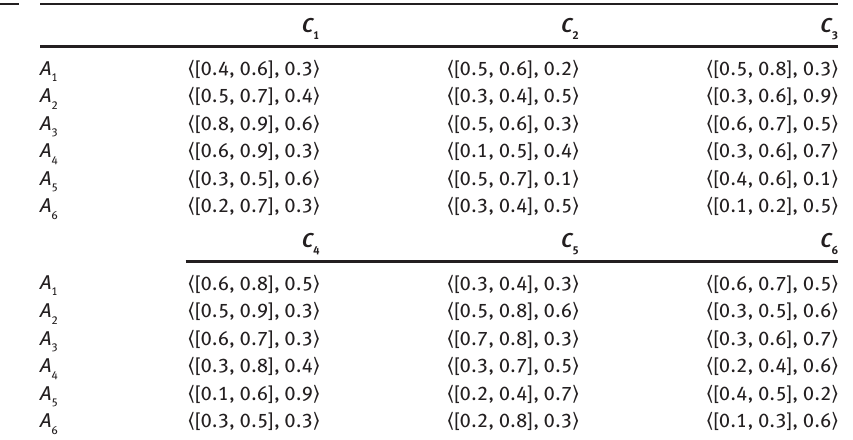
Table 3: Characterization of the Investments of Expert